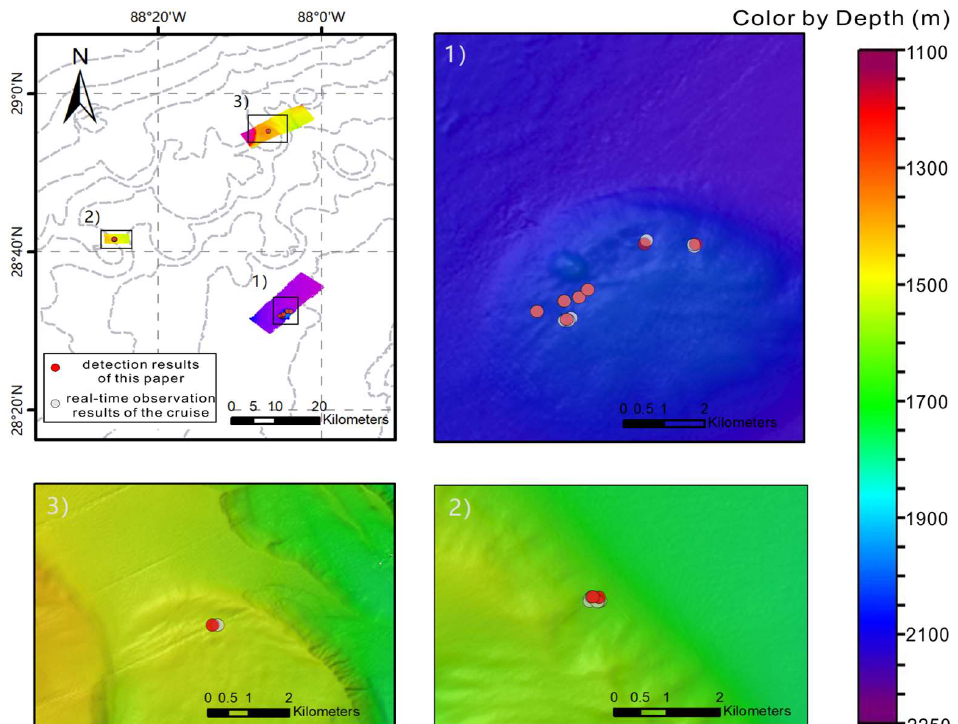
Figure 14. Comparison of the detection results of this paper with the real-time observation results of the cruise. In experimental area 1, large continuous and strong backscattering straight column bubble plumes were detected, indicating active gas leakage in experimental area 1; a single gas plume was detected in experimental areas 2 and 3; the location of the large-scale plume detection in experimental area 1 was basically consistent with that of the plume leakage observed in real time during the cruise, but the plume was too dense to distinguish its single-beam leakage points when using the method in this paper, as shown in Figure 13c,d; the location of the sporadic plume in experimental area 2 and 3 was generally consistent with the location of the seepage observed in real time during the cruise.